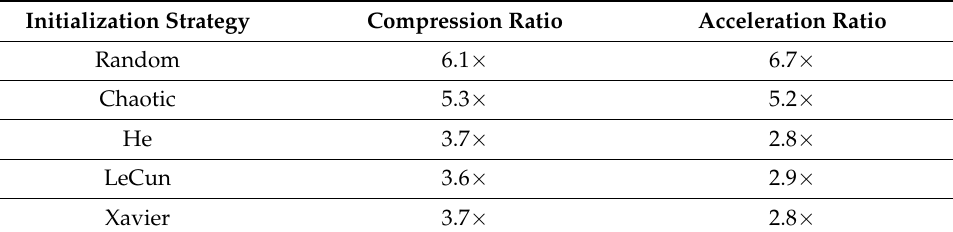
Table 6. Compression and acceleration analysis of the proposed approach on TernausNet.